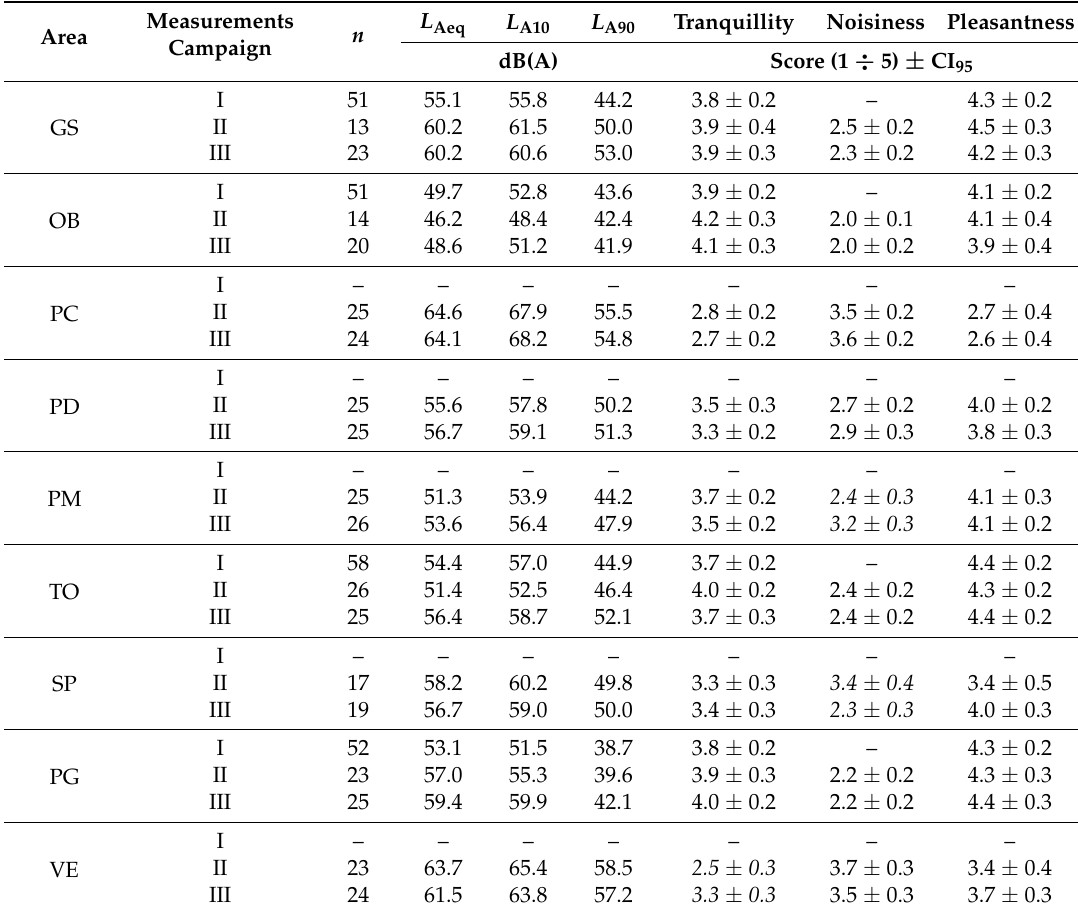
Table 5. Noise and scores results for all measurements campaign in each